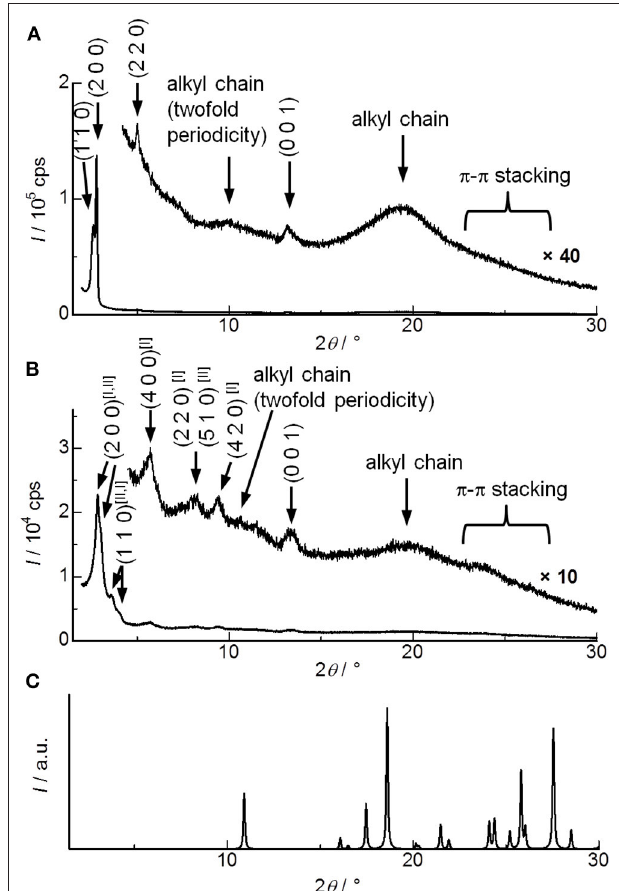
FIGURE 3 | XRD patterns for (A) DHP(8-12)-TCNQ , (B) DHP(2-6)-TCNQ , and (C) TCNQ (simulated from the reported crystal structure) ( Long et al., 1965). Magnified figures of DHP(8-12)-TCNQ and DHP(2-6)-TCNQ in low angle region (2–5 ◦ ) are shown in the insets of Figure 6 (gray line).